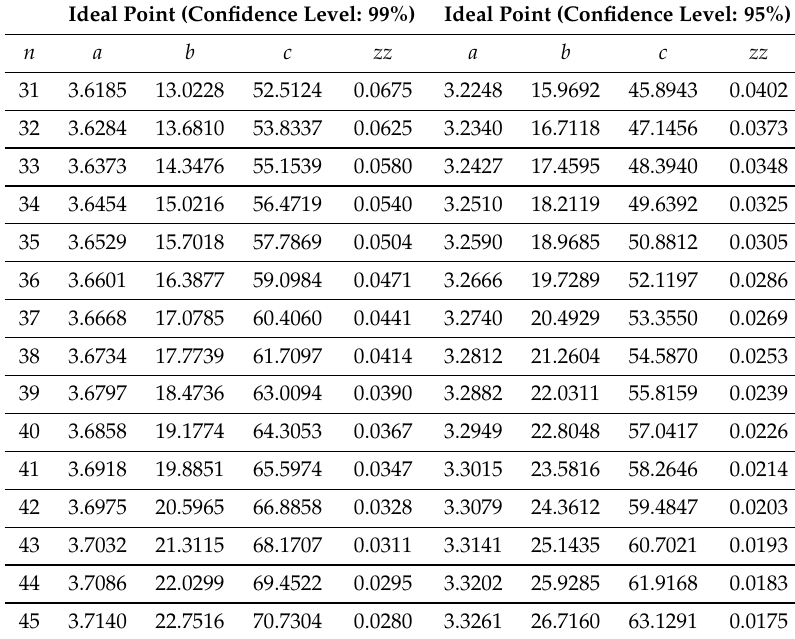
Table 1. Ideal point method (confidence level is 99% and 95%). Ideal Point (Confidence Level: